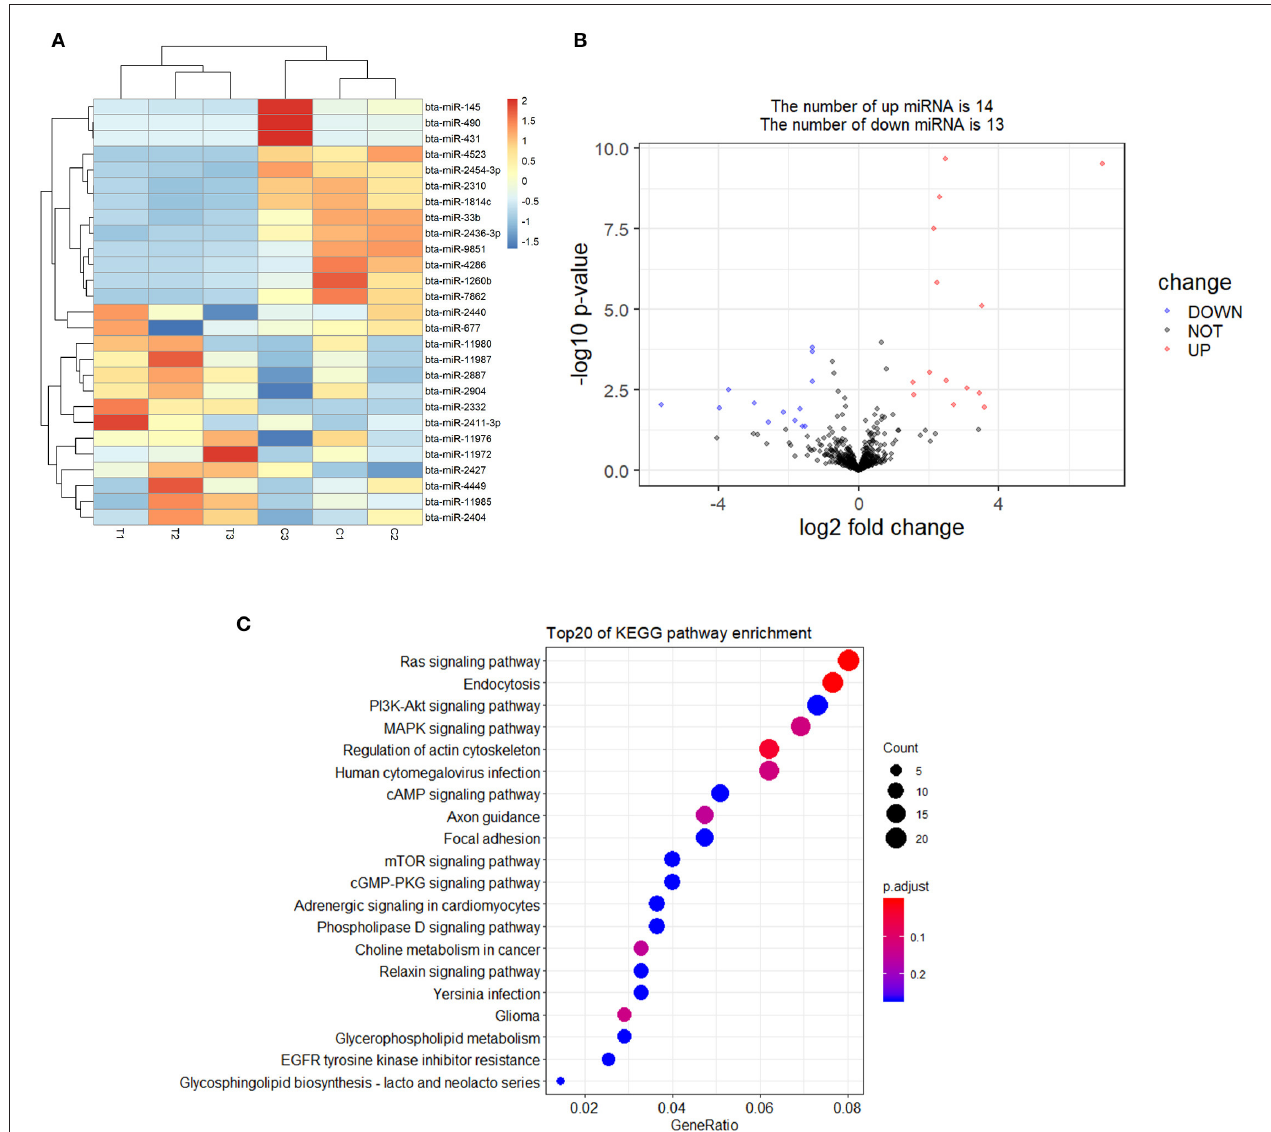
FIGURE 6 | Screening and enrichment analysis of differently expressed miRNAs (DEmiRNAs) in S. aureus infected mammary epithelial cells compared with non-infected mammary epithelial cells. (A) Cluster analysis of DEmiRNAs in mammary epithelial cells between the control group and treatment group. (B) Volcano plot of global DEmiRNAs in mammary epithelial cells between the control group and treatment group. (C) KEGG pathway classified annotation of DEmiRNAs in mammary epithelial